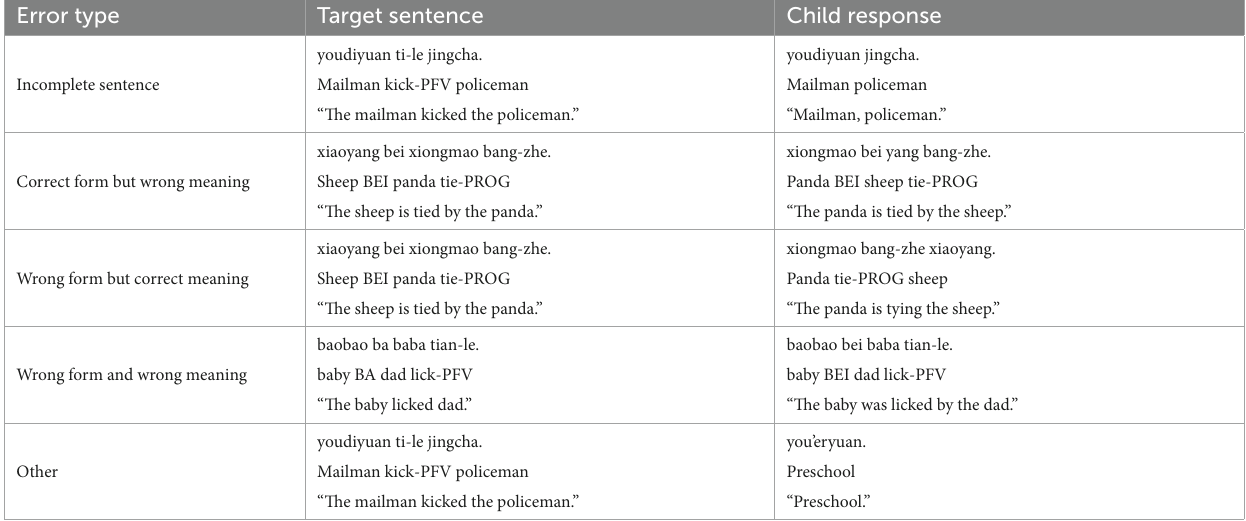
TABLE 6 Errors in sentence